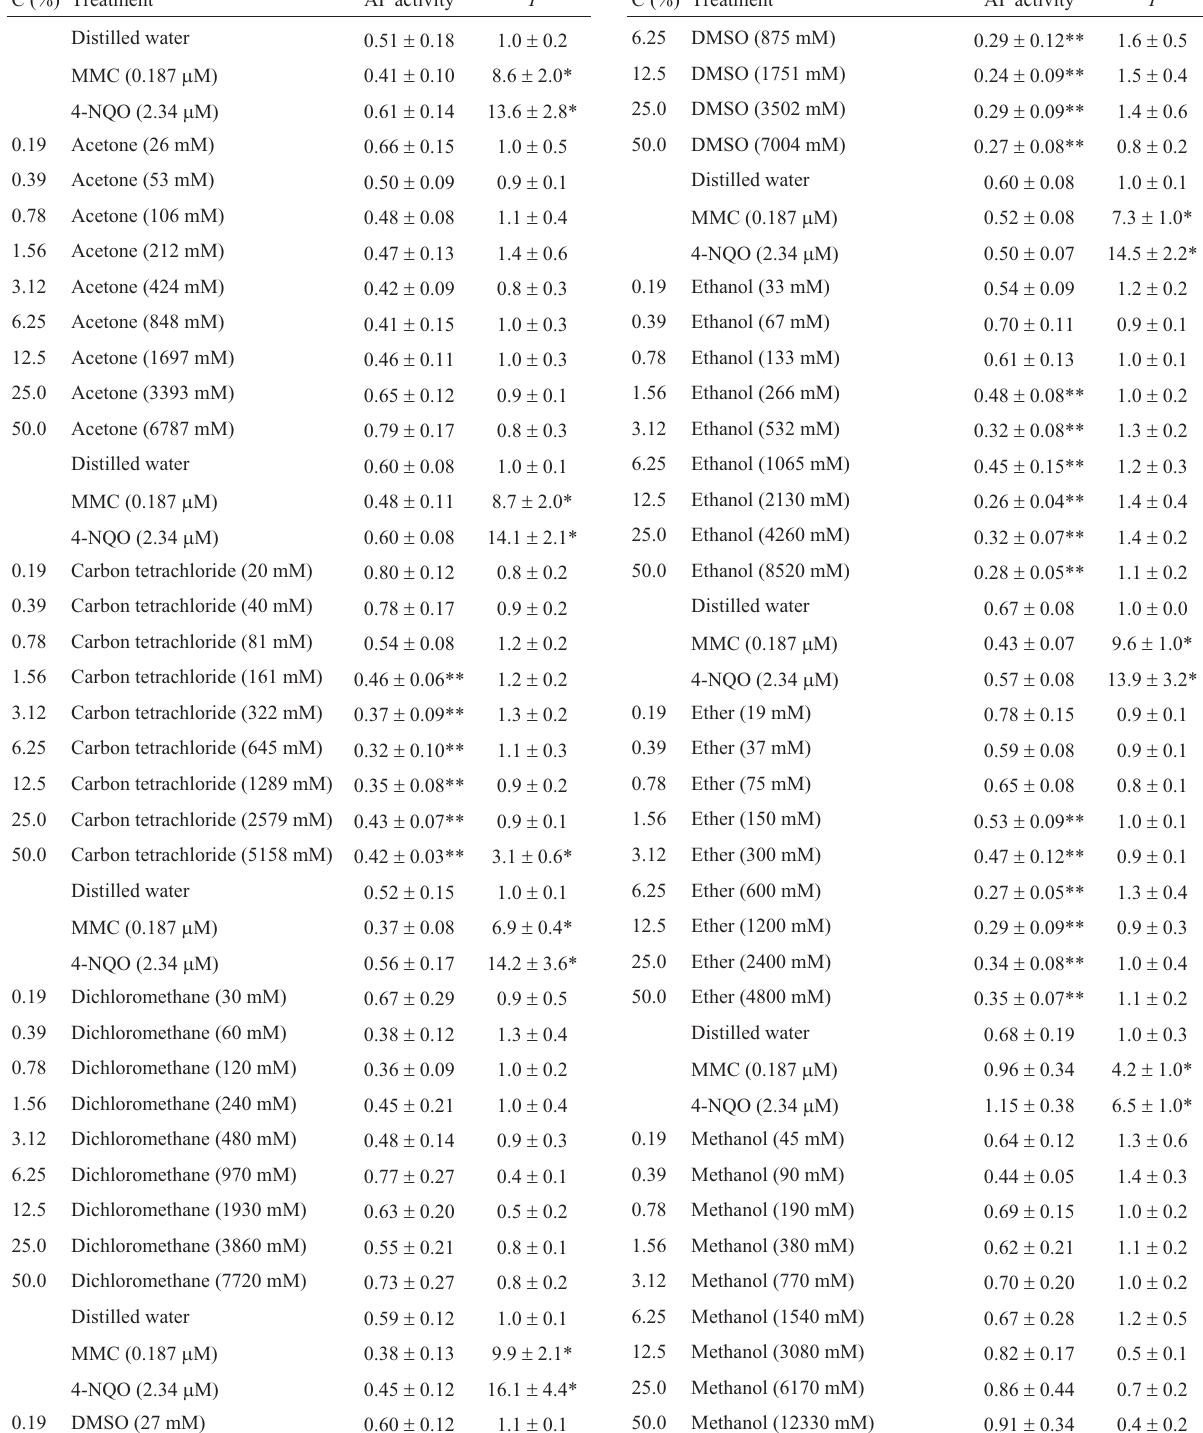
Table 2 - Alkaline phosphatase (AP) activities and the SOS induction factor ( I ) in E. coli PQ37 cells treated with organic